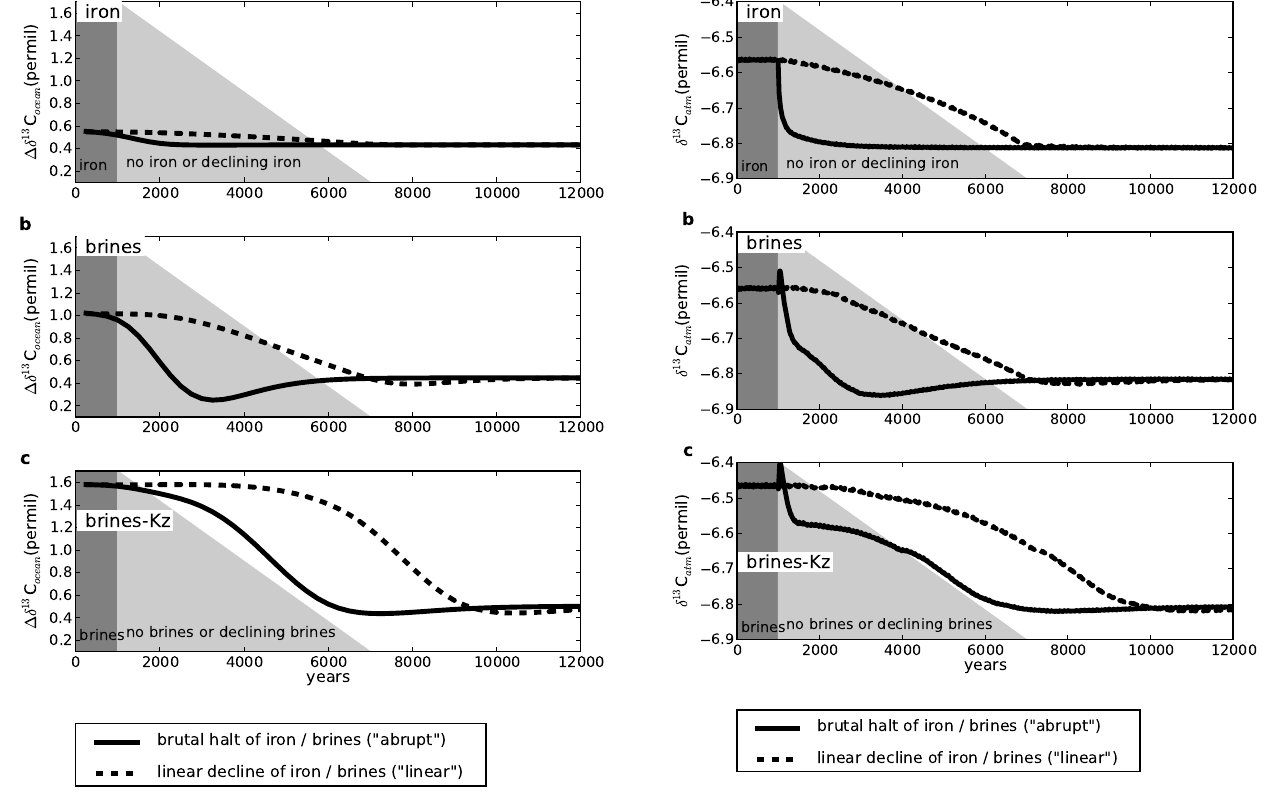
Fig. 4. Evolution of atmospheric δ 13 C atm with a constant climate for three mechanisms: (a) iron fertilization, (b) sinking of brines and (c) sinking of brines and interactive vertical